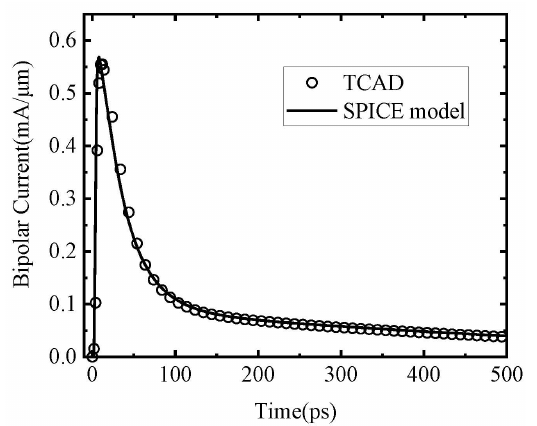
Figure 8. Comparison between the TCAD simulation result and the SPICE model of the bipolar amplification